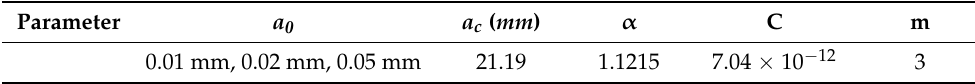
Table 9. The value of